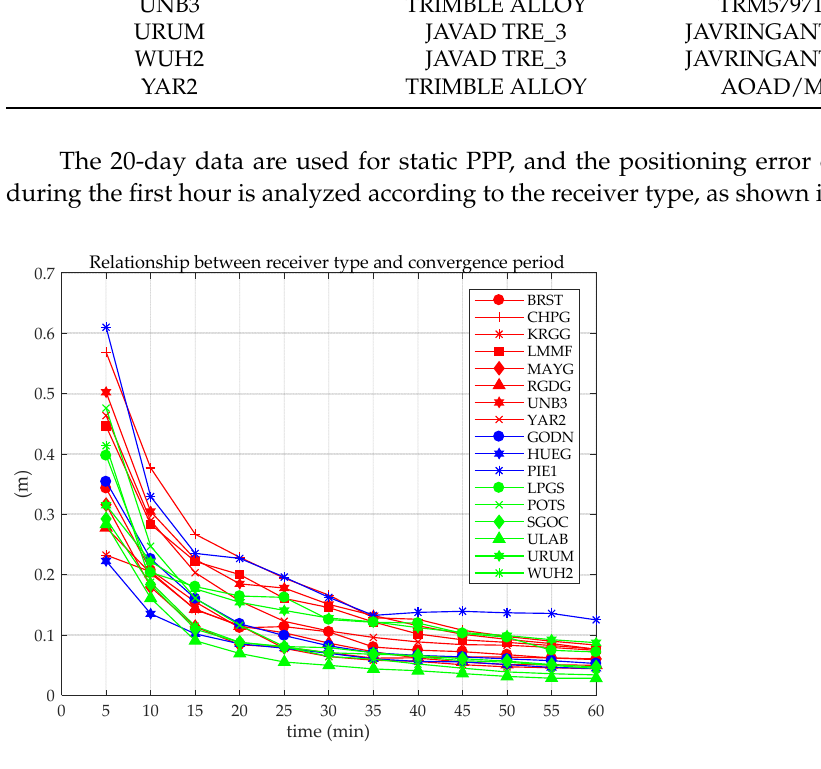
Figure 13. Positioning error in the previous hour for different receiver types (red: TRIMBLE ALLOY; blue: JAVAD TRE_3 DELTA; green: JAVAD TRE_3).